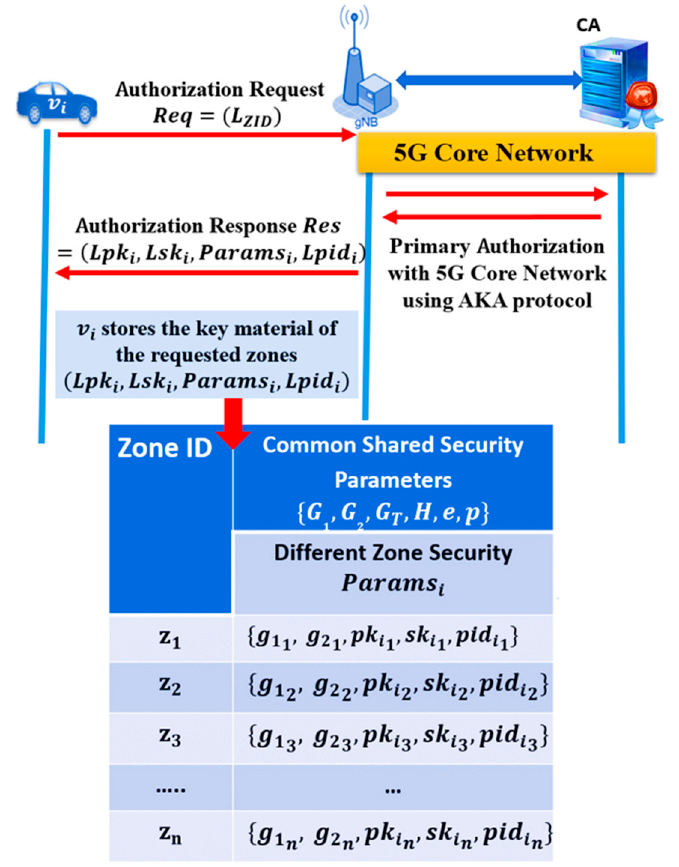
Figure 4. Vehicle primary authorization.